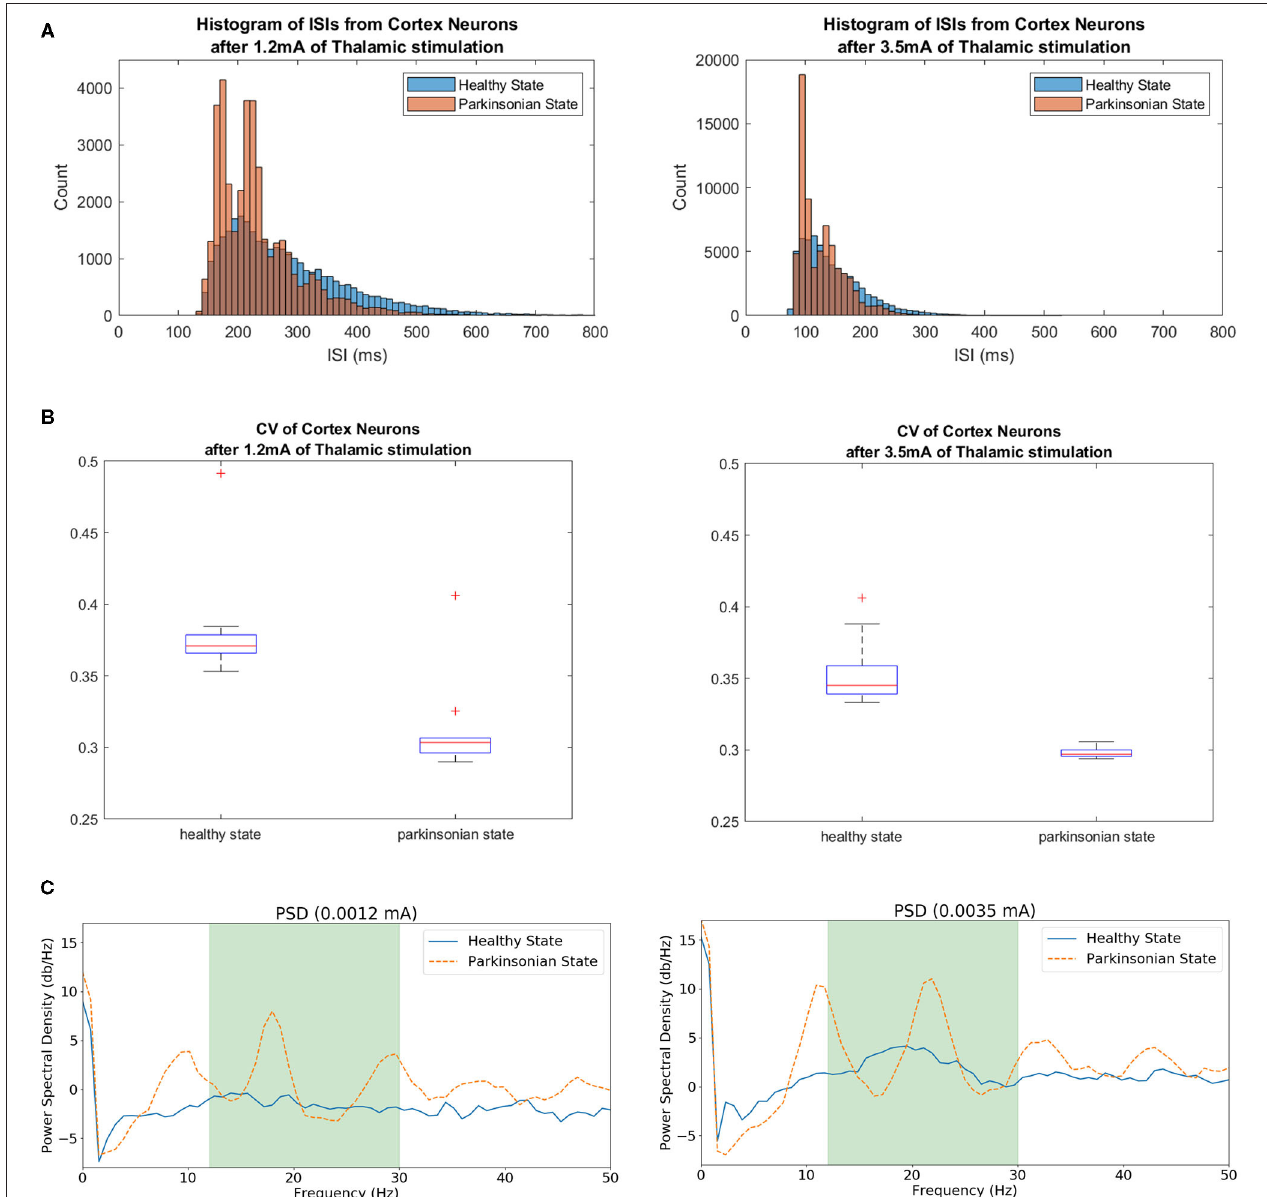
FIGURE 15 | In (A) , histograms of ISIs from simulations under different thalamic stimulation (1.2 and 3.5 mA) in both conditions of the model. The range for each histogram was adapted since a higher thalamic stimulation increases the neuronal activity from CTX, producing even more spikes. A higher concentration of the same intervals between spikes indicate the reduction of variability when the parkinsonian condition is activated in both scenarios. (B) Shows the coefficient of Variance of cortical neurons after two thalamic stimulation. The variability was tested in both scenarios for both conditions of the model. The box plots show a reduction of variability when the parkinsonian condition is activated. It also shows a bigger concentration of ISI values. (C) Exhibits Power Spectrum Density (PSD) of cortical neurons under 1.2 and 3.5 mA of thalamic stimulation. Both conditions of the model were tested. The green area indicates the beta band range (13–30 Hz). The peaks within the range shows the enhance in beta activity detected after activating the parkinsonian